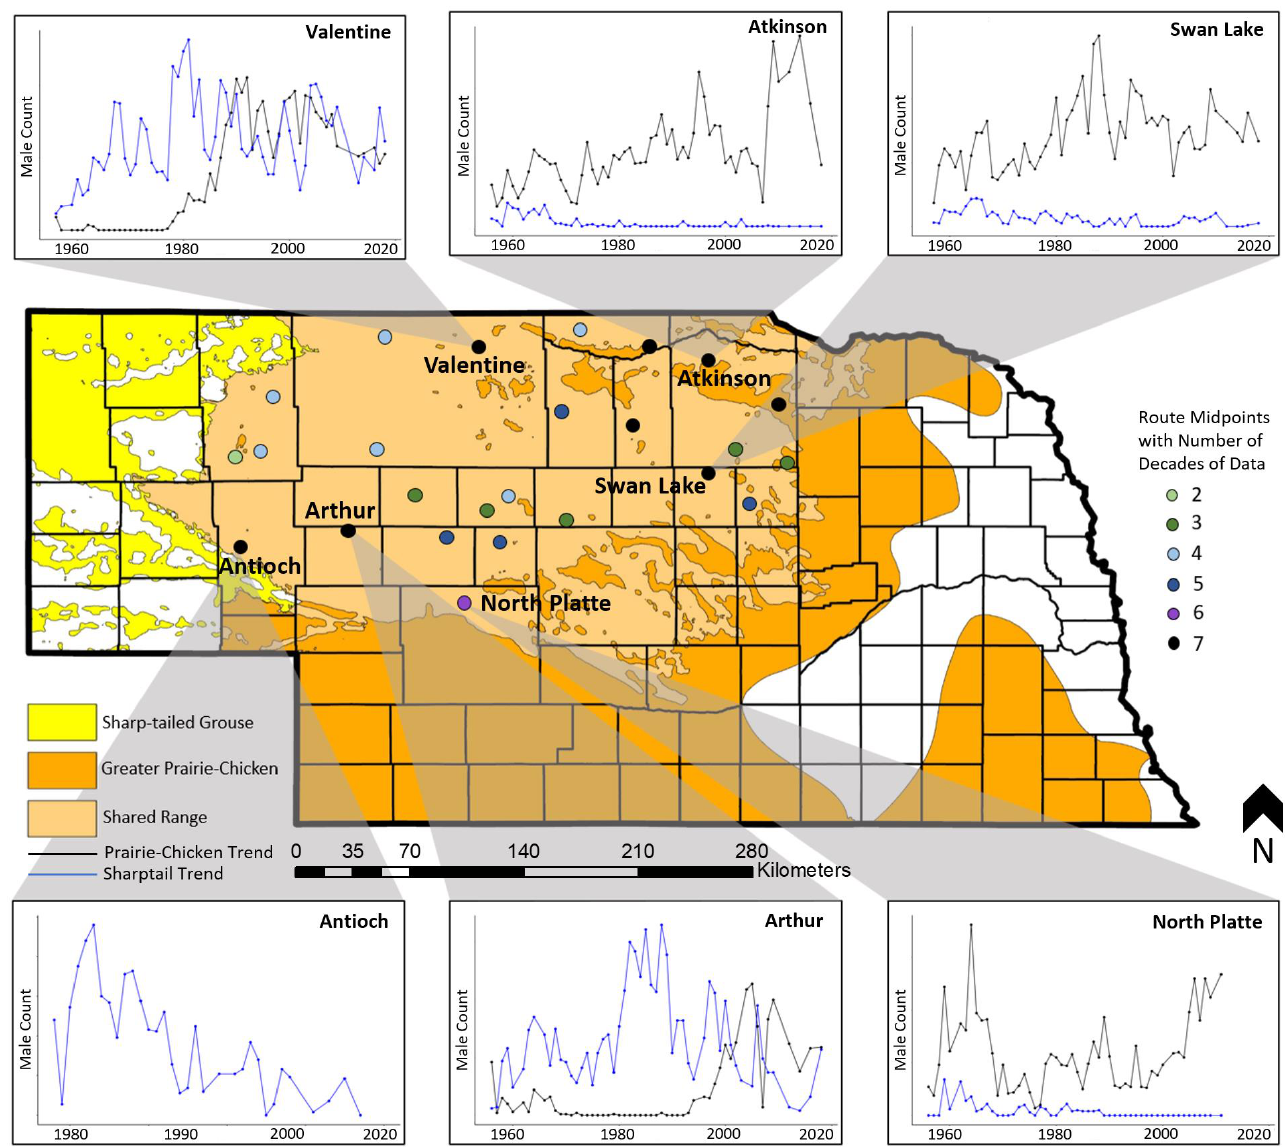
Figure 5. A subset of prairie grouse spring breeding ground count time series from 1956 to 2018, by route, in the Sandhills of Nebraska, USA, emphasizing spatial variation in counts over time across the species’ respective ranges. Each time series inset depicts the number of males observed on a route, with sharptails represented in blue and prairie-chickens shown in black. The absence of a species from a time series indicates the species was never observed at that location. The colors of the route midpoints represent the number of decades of data collected on each route.